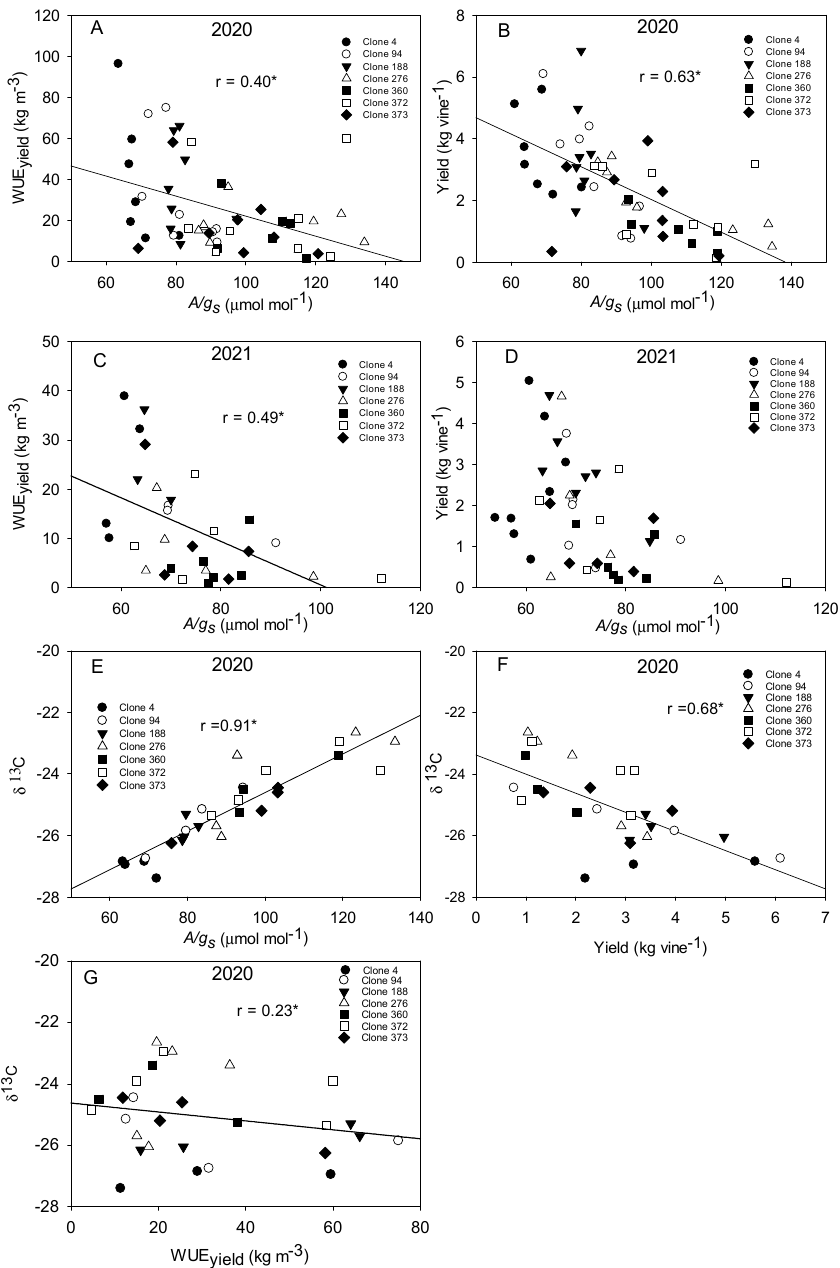
Figure 2. ( A ) Relationship between average A/g s measured from fruit set to harvest in the morning, and productive WUE in 2020. ( B ) Relationship between average A/g s measured from fruit set to veraison in the morning and midday, and yield at harvest in 2020. ( C ) Relationship between average A/g s measured in the morning at pre-veraison period, and productive WUE (WUE yield ) in 2021. ( D ) Relationship between average A/g s measured in the morning at pre-veraison period, and yield in 2021. ( E ) Relationship between average A/g s measured during the whole season (pre- and post-veraison period, early morning and midday) and carbon isotopic δ 13 C in berries in 2020. ( F ) Relationship between yield at harvest and carbon isotopic δ 13 C in berries in 2020. ( G ) Relationship between WUE yield and carbon isotopic δ 13 C in berries in 2020. Each point represents the measurement in a single vine for the different clones and under control and stress conditions. *, indicate significant differences at the 0.1 levels of